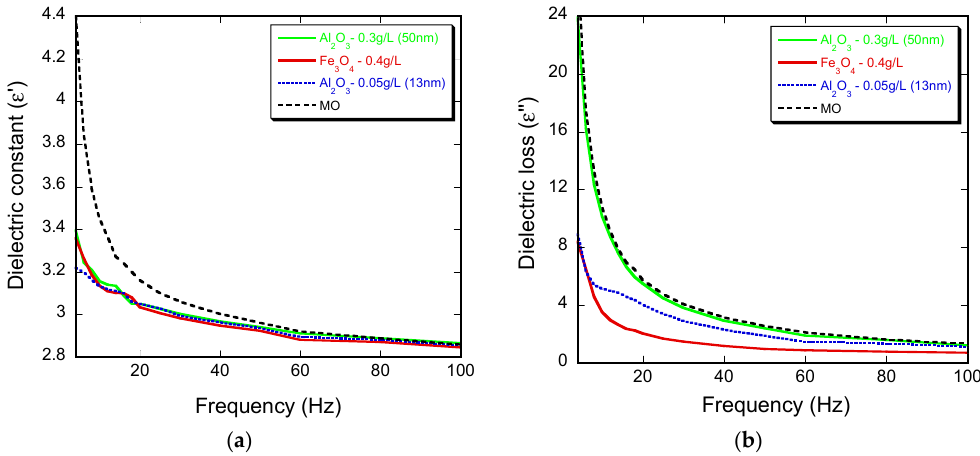
Figure 3. ( a ) Real and ( b ) imaginary parts of the relative dielectric permittivity vs. the frequency of the investigated nanofluids.